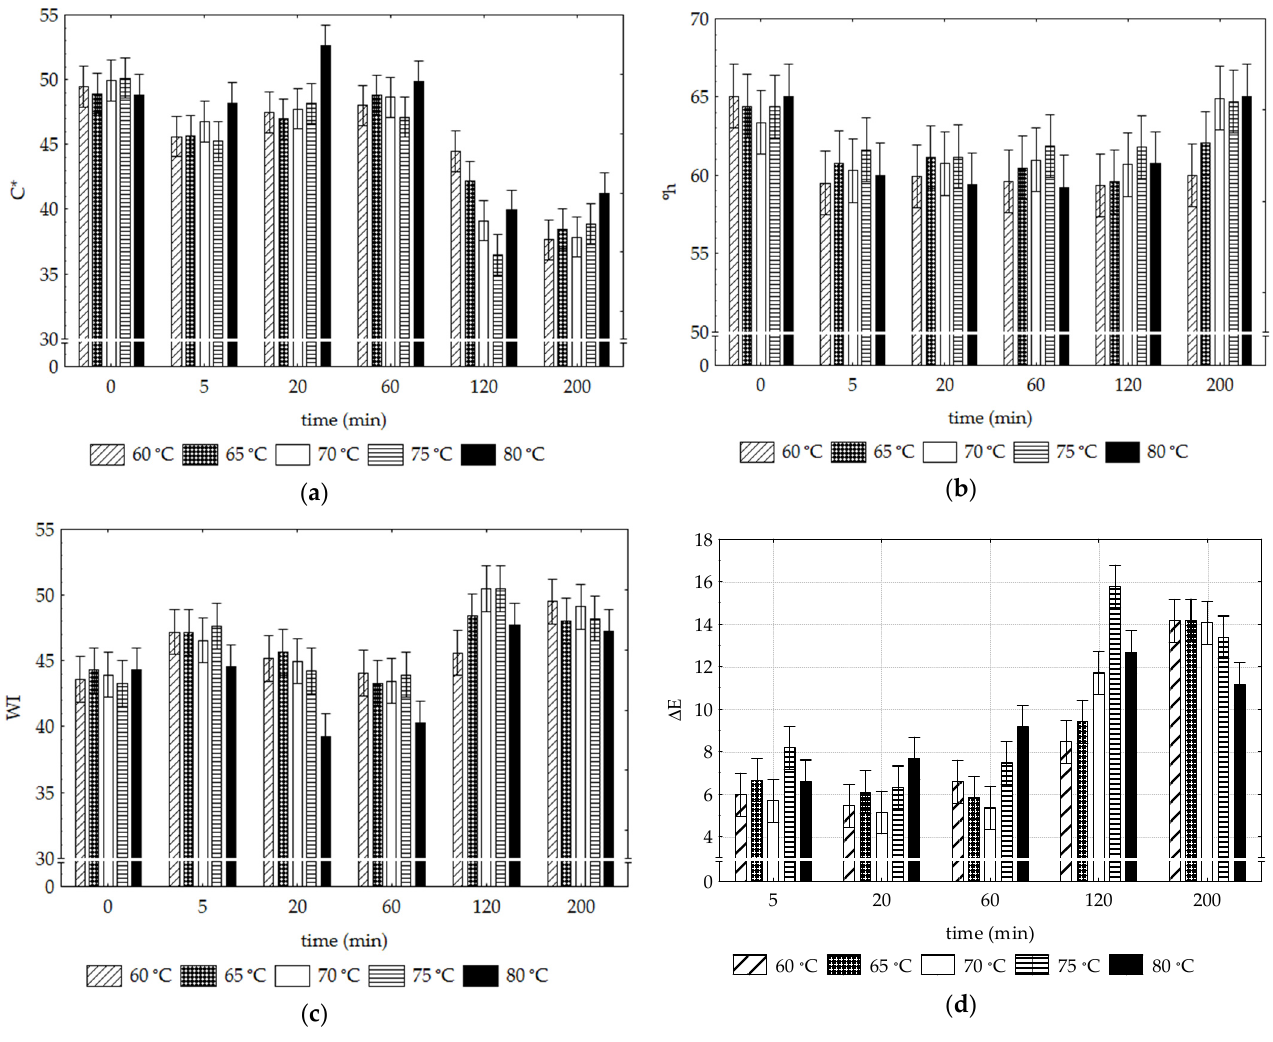
Figure 3. SP samples’ color indices change as a function of temperature and time of drying: ( a ) C* (Chroma), ( b ) °h (Hue angle), ( c ) WI (Whiteness Index) and ( d ) Δ E (Total Color Difference). Vertical bars denote 0.95 confidence intervals.